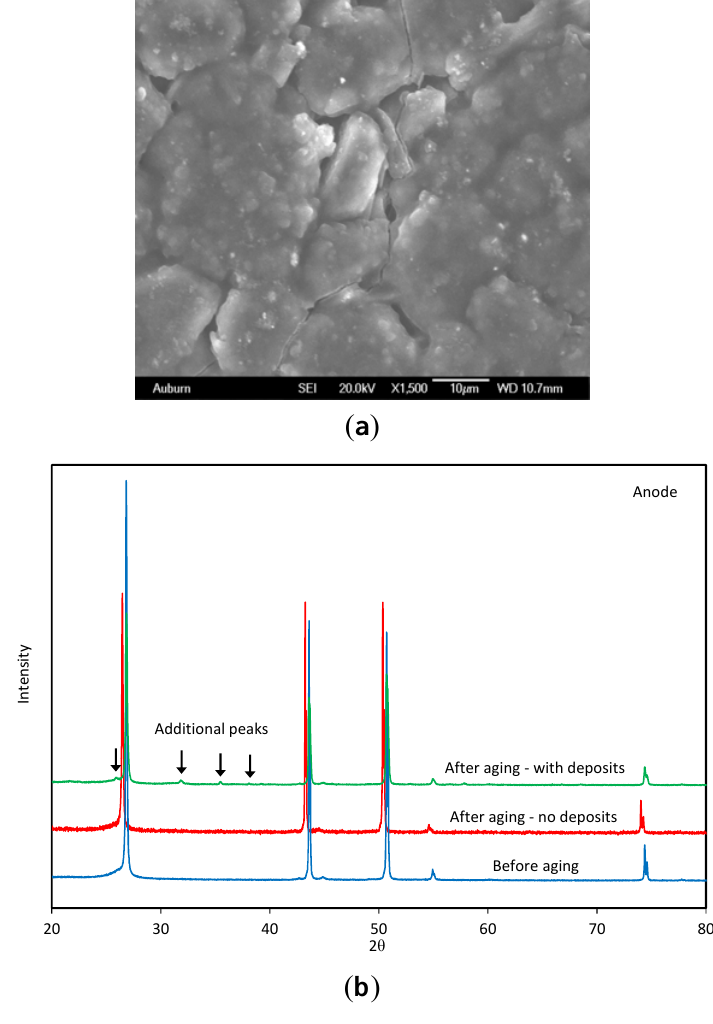
Figure 4. Structural changes on the anode electrode from degradation. ( a ) Surface cracks on the sufrcae of aged anode electrode; ( b ) XRD spectra of aged anode electrode showing change in cystal structure (new